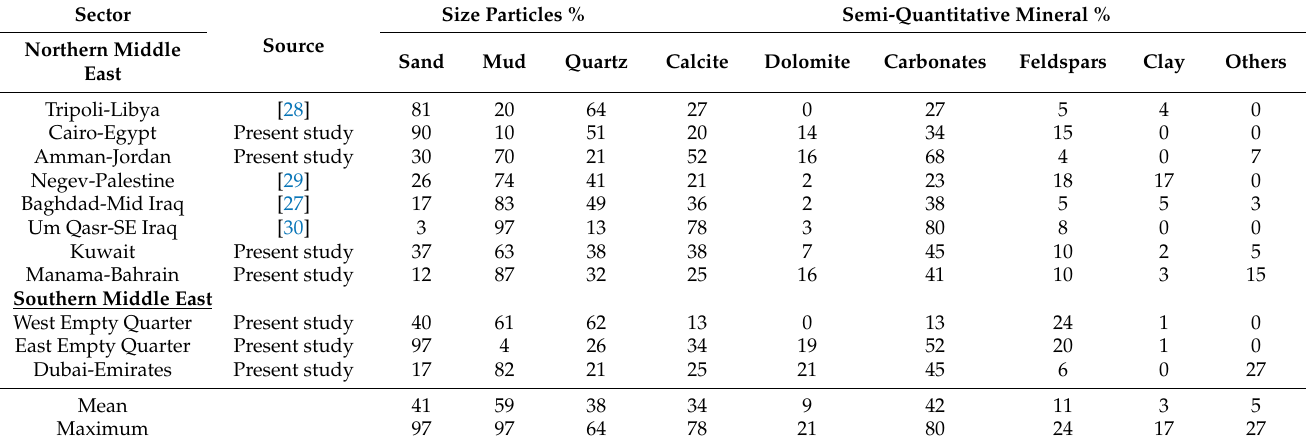
Table 4. Mean grain size and mineral percentages of deposited dust samples from upwind to downwind in the northern (Tripoli-Libya to Manama-Bahrain) and southern (West Empty Quarter to Dubai-Emirates) Middle